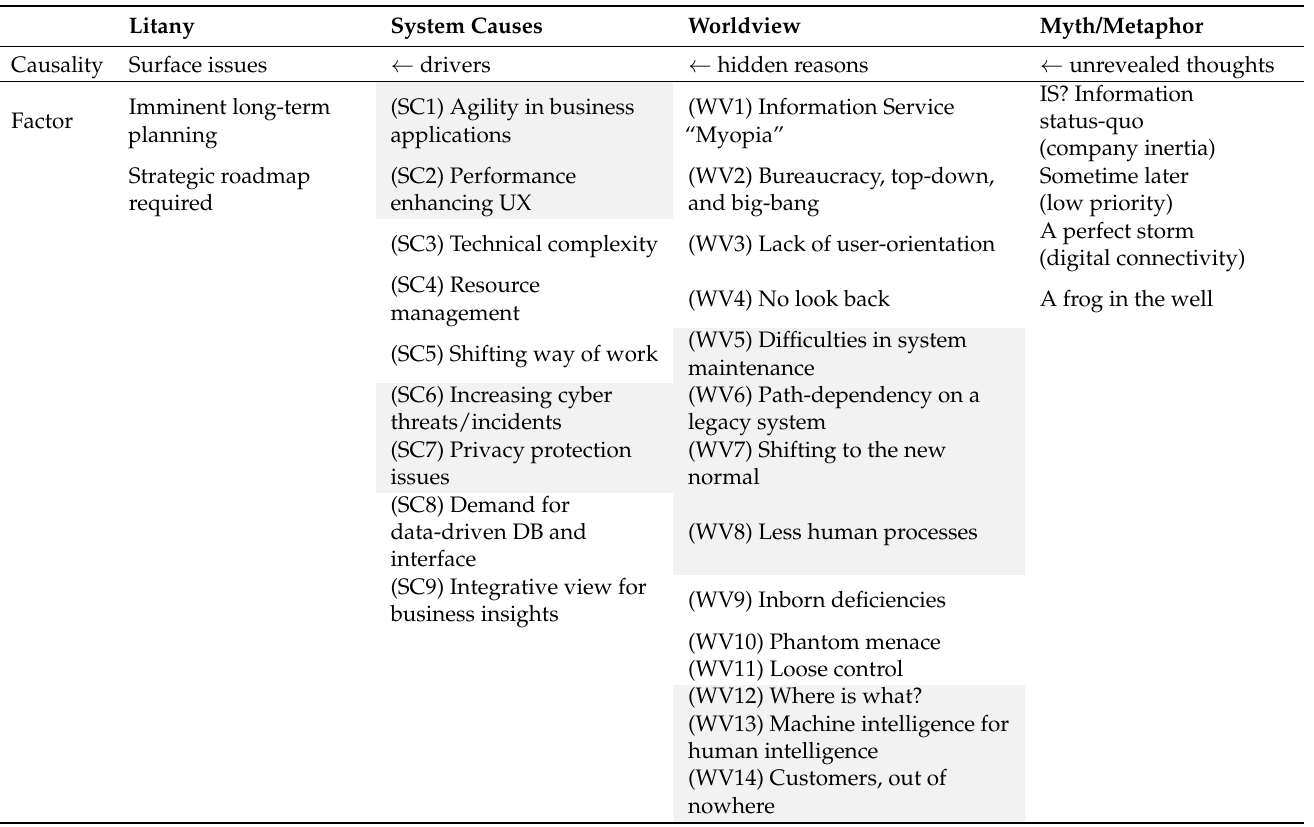
Table 4. Summary of CLA results.